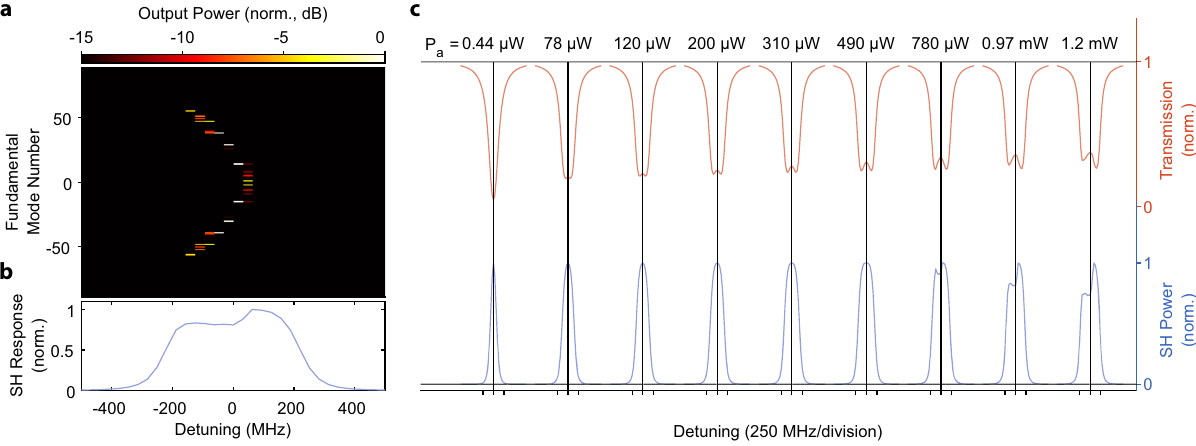
Fig. 7 Simulated effect of 1% disorder in the mode-to-mode loss rates on the cascaded OPO. a Cascaded OPO signal as a function of pump detuning, simulated at 0.97 mW of pump power. b Second Harmonic lineshape corresponding to the cascaded OPO in panel ( a ). c Lineshape evolution as a function of power, asymmetry is developed below 780 μ W, which agrees with the experiment.